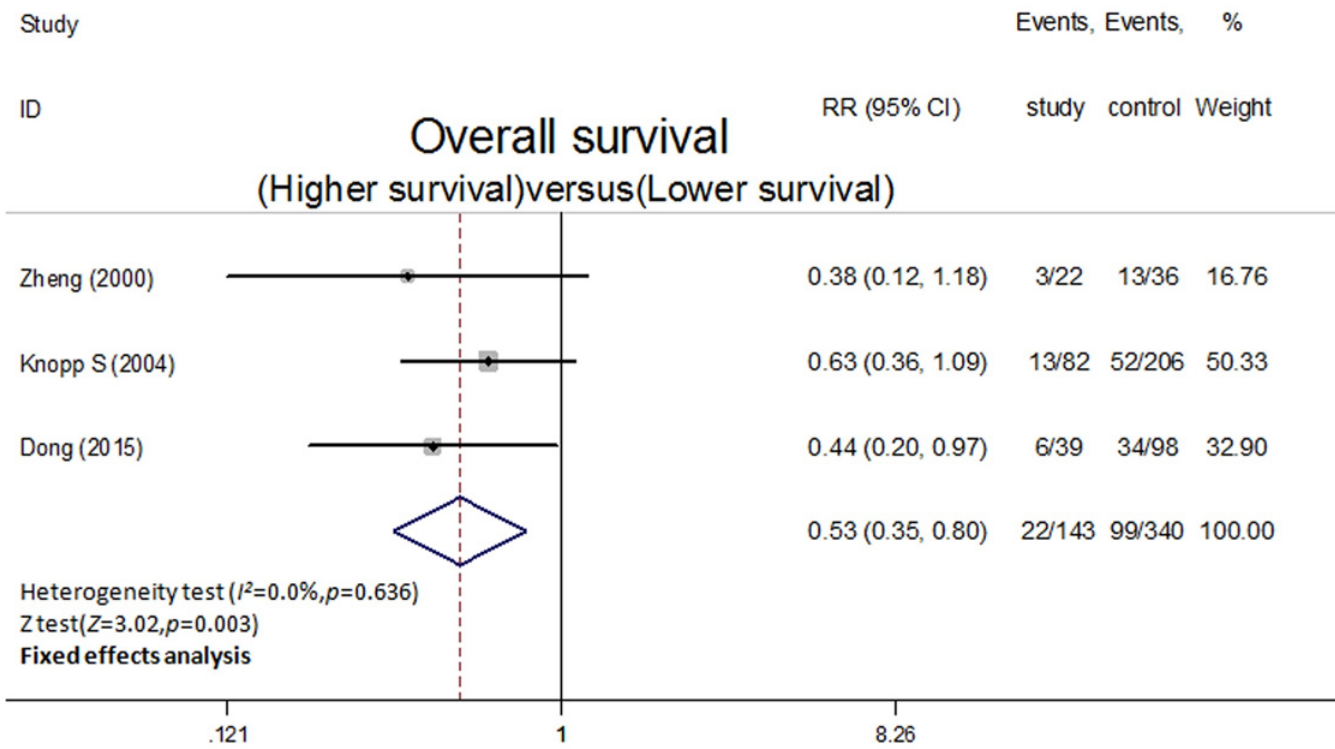
Fig 3. Forest plot for the association between p16INK4a expression and